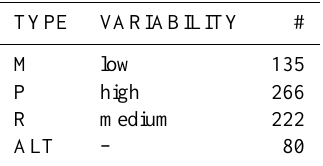
Table 3. Classification of ground-based stations (function of diurnal variability): 4 classes with the number of sites available (following Flemming, 2005). The fourth class (ALT) is special: it groups to- gether all the ground stations situated at altitude (above 900 m).